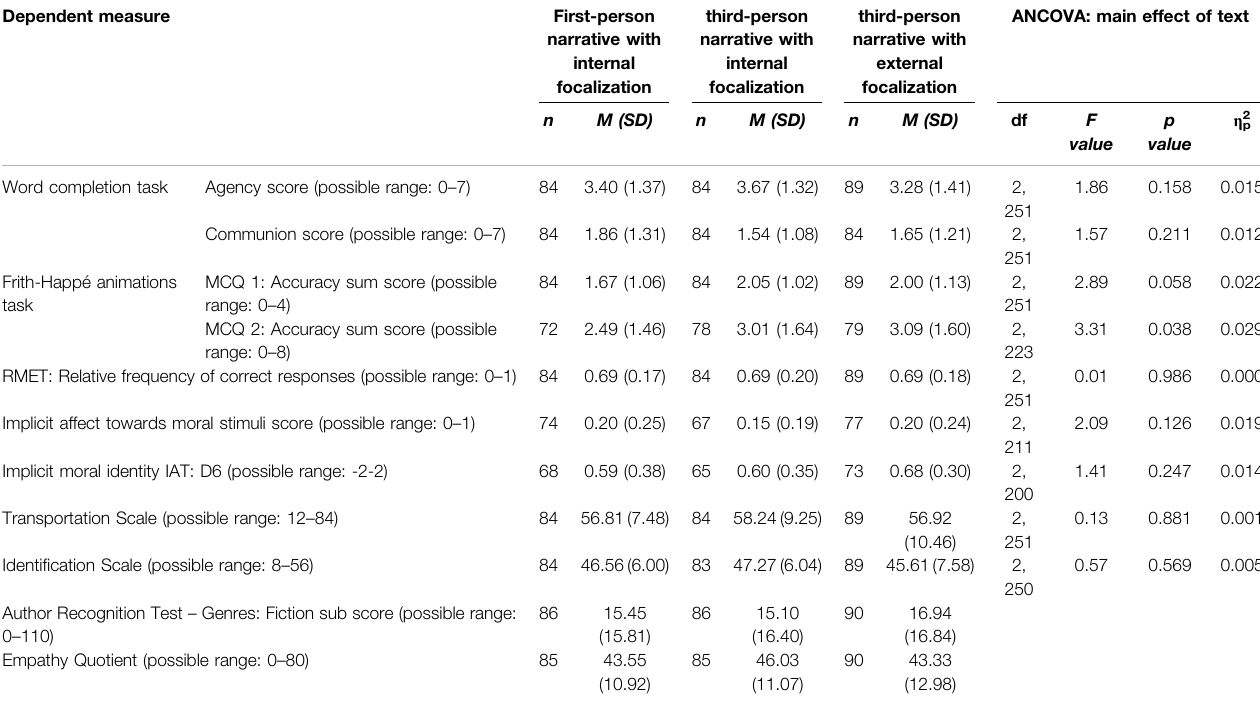
TABLE 5 | Experiment 2: Descriptive statistics for each dependent measure in each experimental group, and ANCOVA results for the main effect of text. Dependent measure